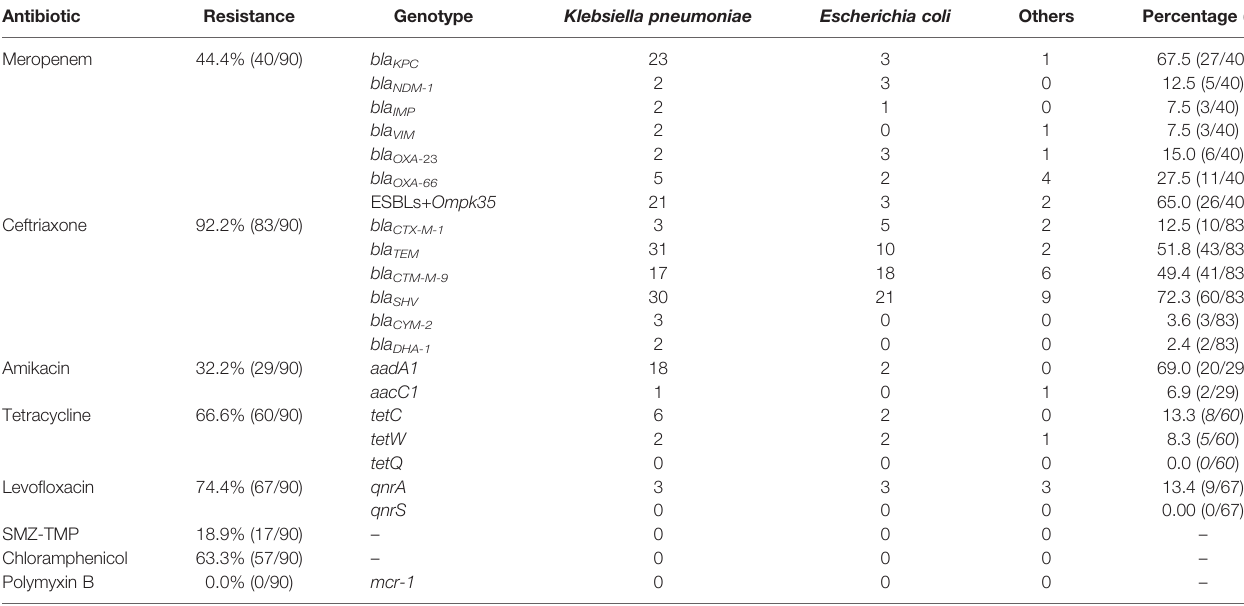
TABLE 2 | Antimicrobial susceptibility test (AST) and antimicrobial resistance genotyping of multidrug-resistant Enterobacteriaceae (MDRE) .